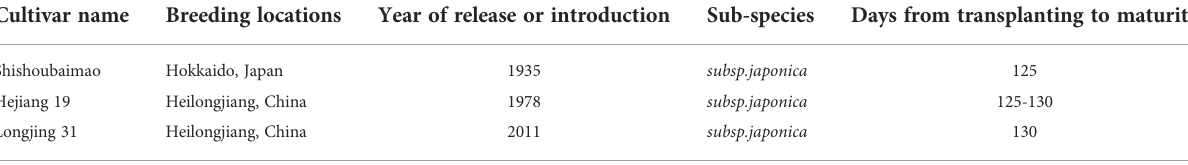
TABLE 1 Cultivar name, year of release or introduction, sub-species and days from transplanting to maturity for the chosen three rice